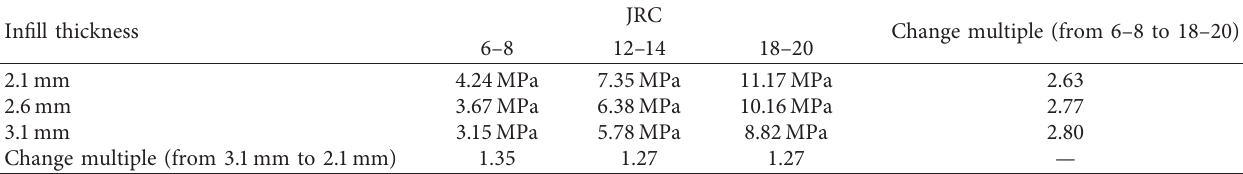
Change multiple (from 3.1 mm to 2.1mm) — Table 4: Relationship between peak shear stress and coupling of joint roughness and infill thickness for bolted infilled rock joints. JRC Infill thickness